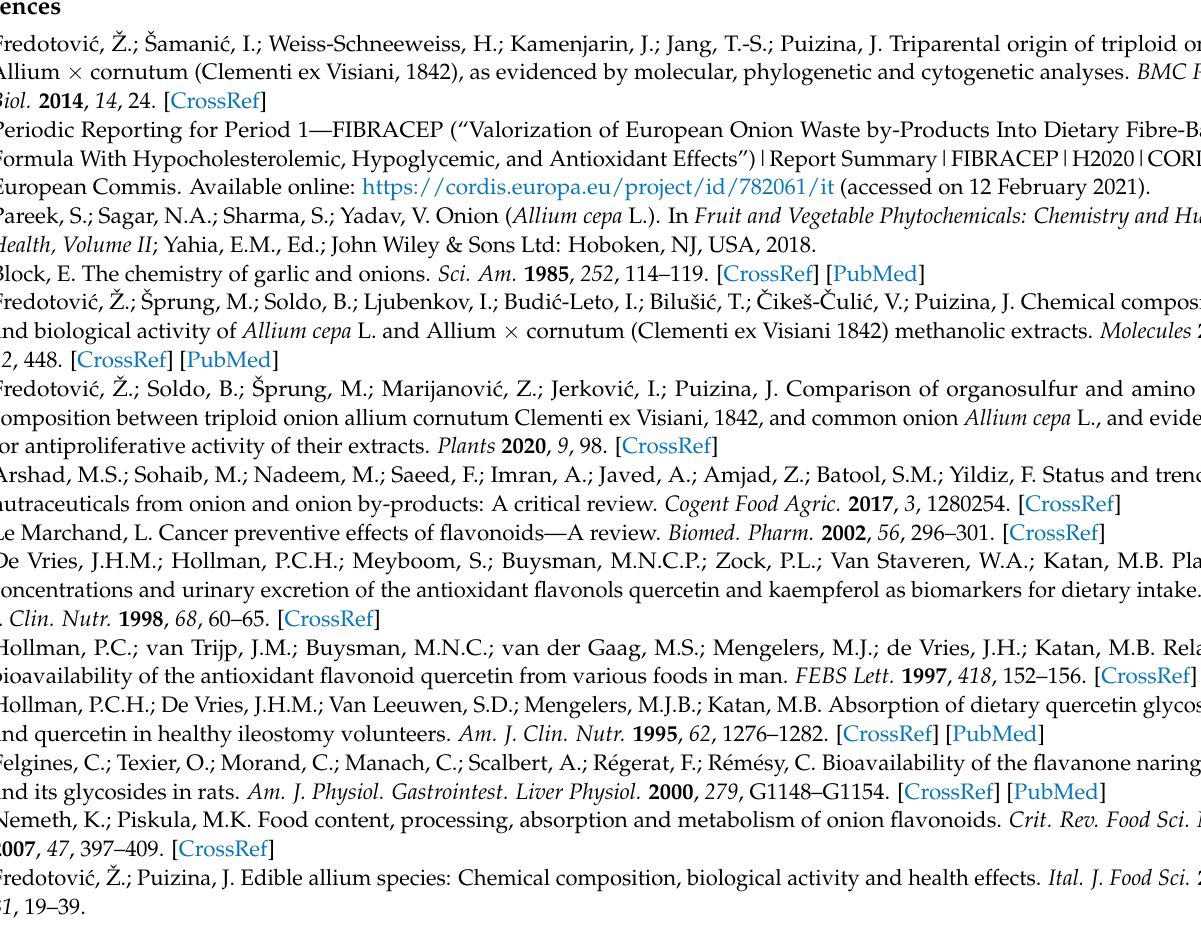
Table S1: Preparation of stock solutions of stimulated digestive